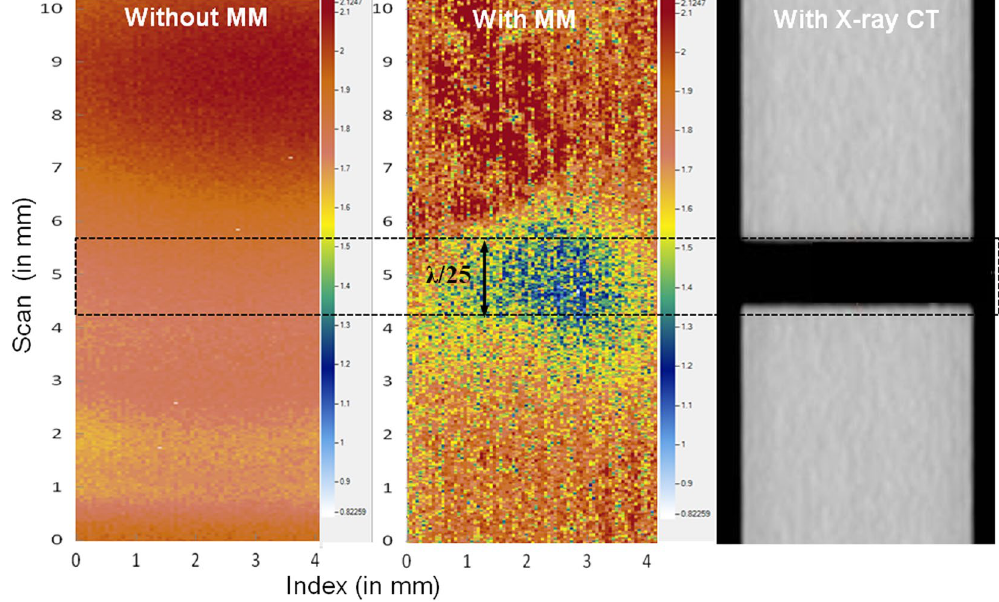
Figure 4. Image obtained by ultrasonic immersion C-scan without and with metamaterial lens, in comparison with that from X-ray μ CT